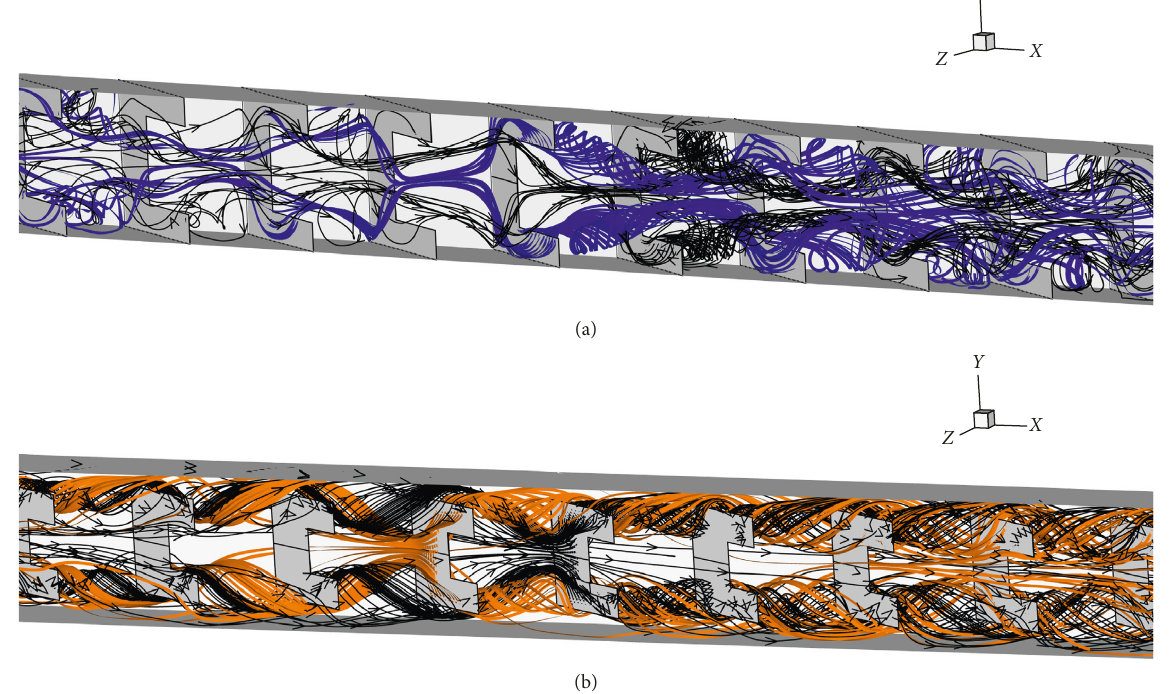
Figure 4: Longitudinal vortex flow for the square channel heat exchanger installed with V-orifice at (a) b15g0 and (b) b15g10 for Re and V-downstream